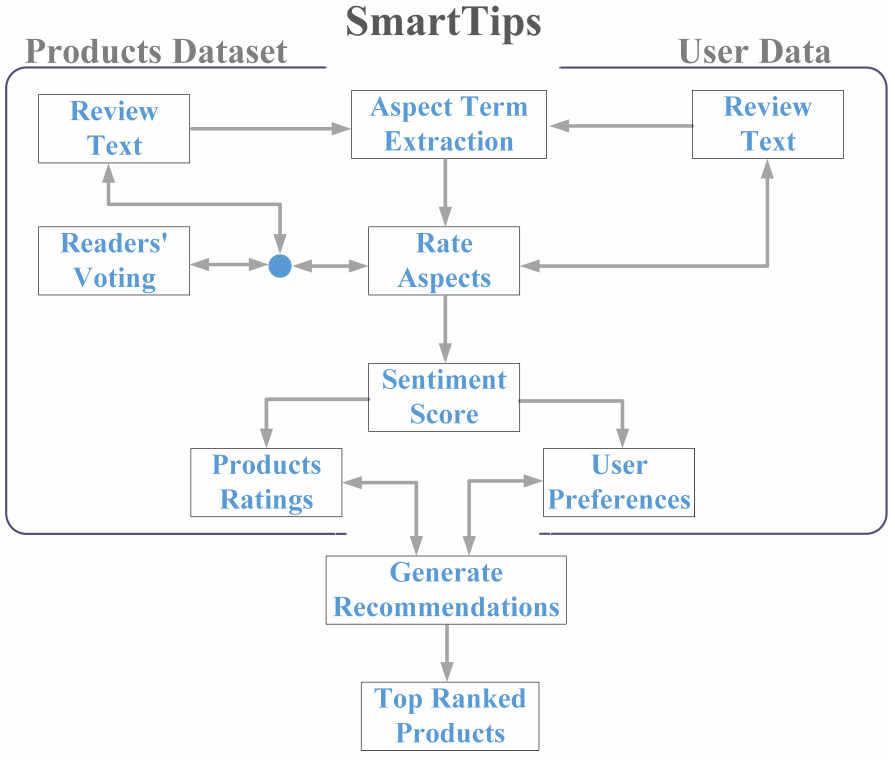
Figure 3. The overall scheme of the proposed recommender